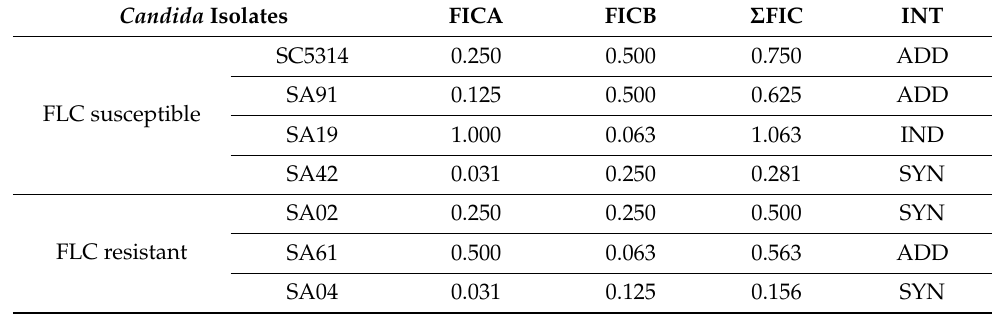
Table 2. Antifungal activity of human neutrophil B peptide in combination with fluconazole in a 1:1 ratio against fluconazole susceptible and fluconazole resistant Candida albicans isolates.